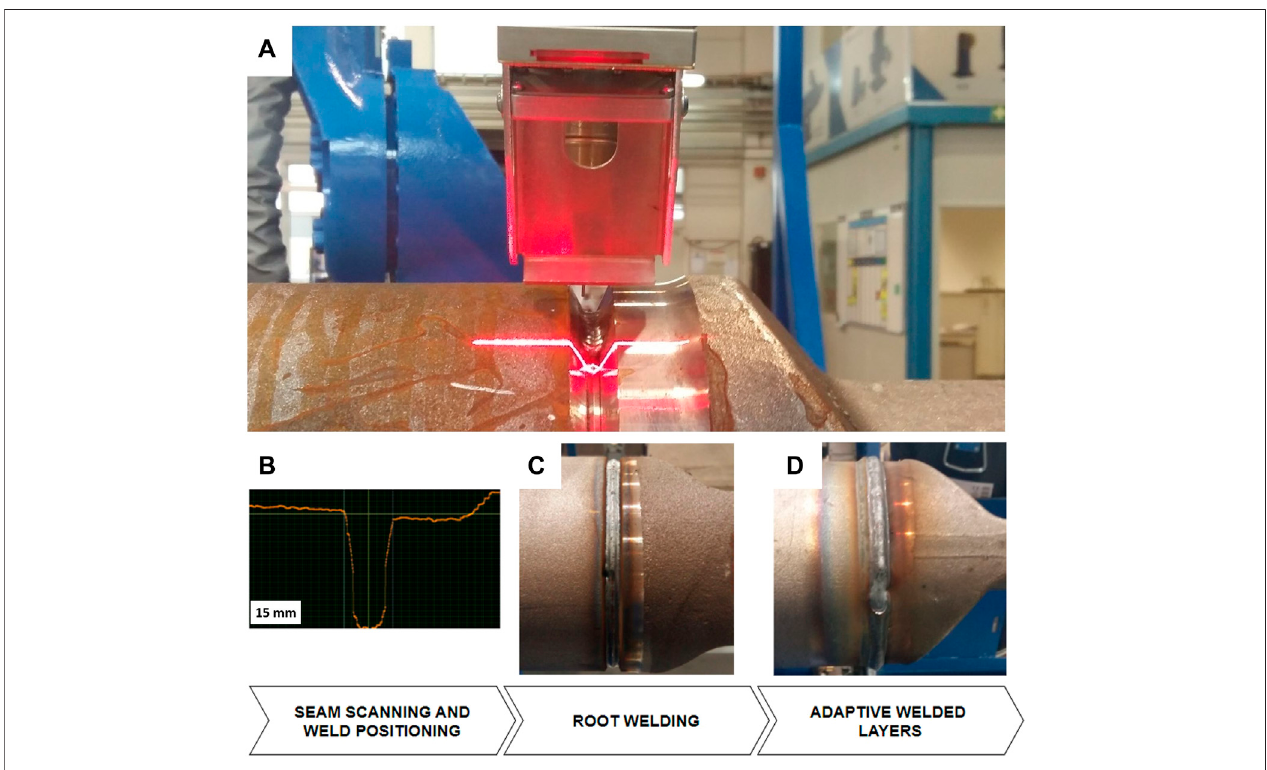
FIGURE7| Exampleofadaptive multilayerwelding wherethewelding areais fi rstscannedin3D (A,B) ;then, aroot weldismade (C) ,and fi nally,multiplelayersare adaptively added (D) .